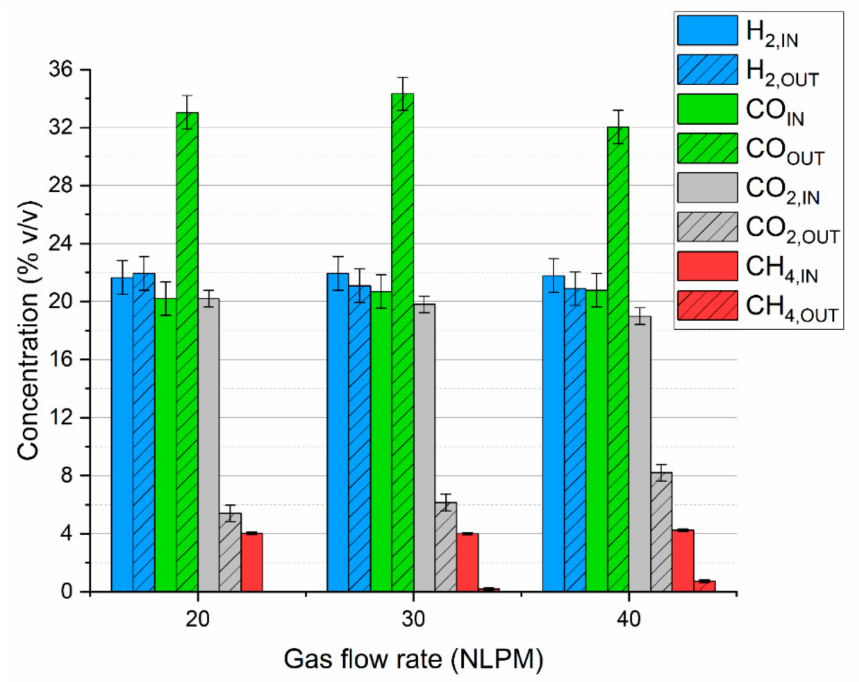
Figure 2. Microwave plasma impact on syngas composition depending on the gas flow rate.